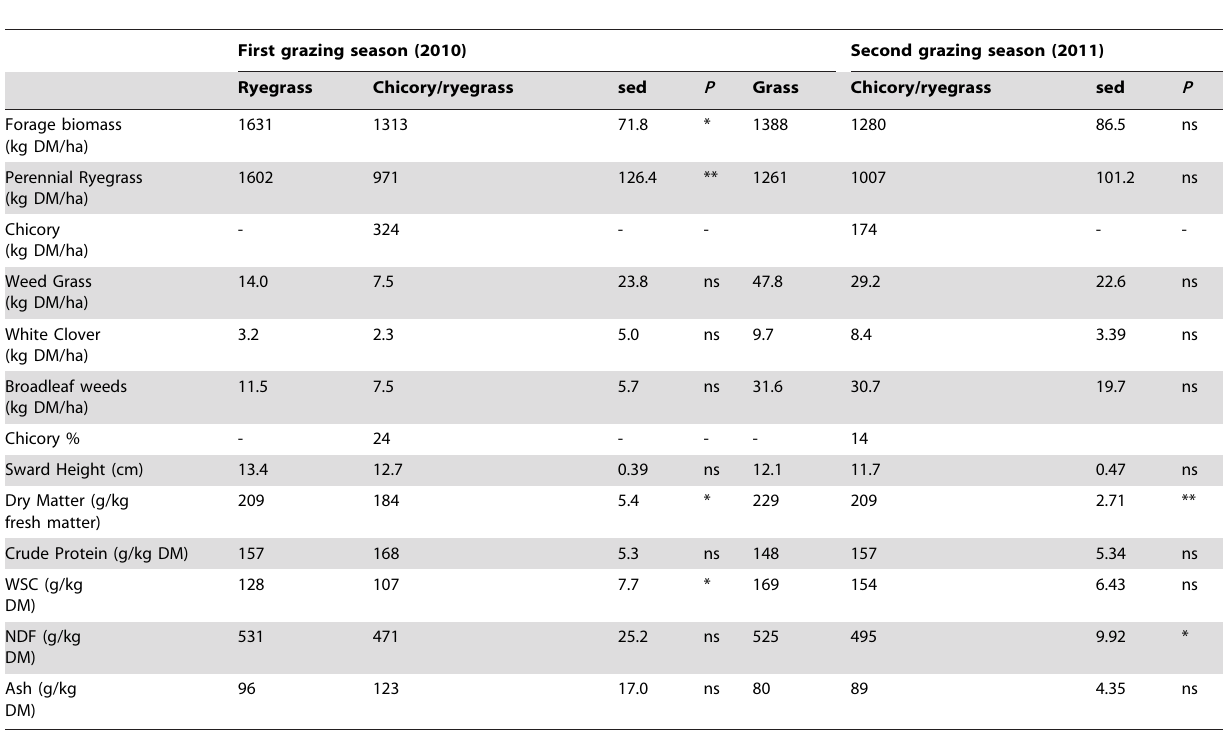
Table 2. Mean forage biomass, botanical composition, sward height, forage DM and chemical composition of grazed plots within each grazing season (2010 ( n =11) and 2011 ( n =14)).